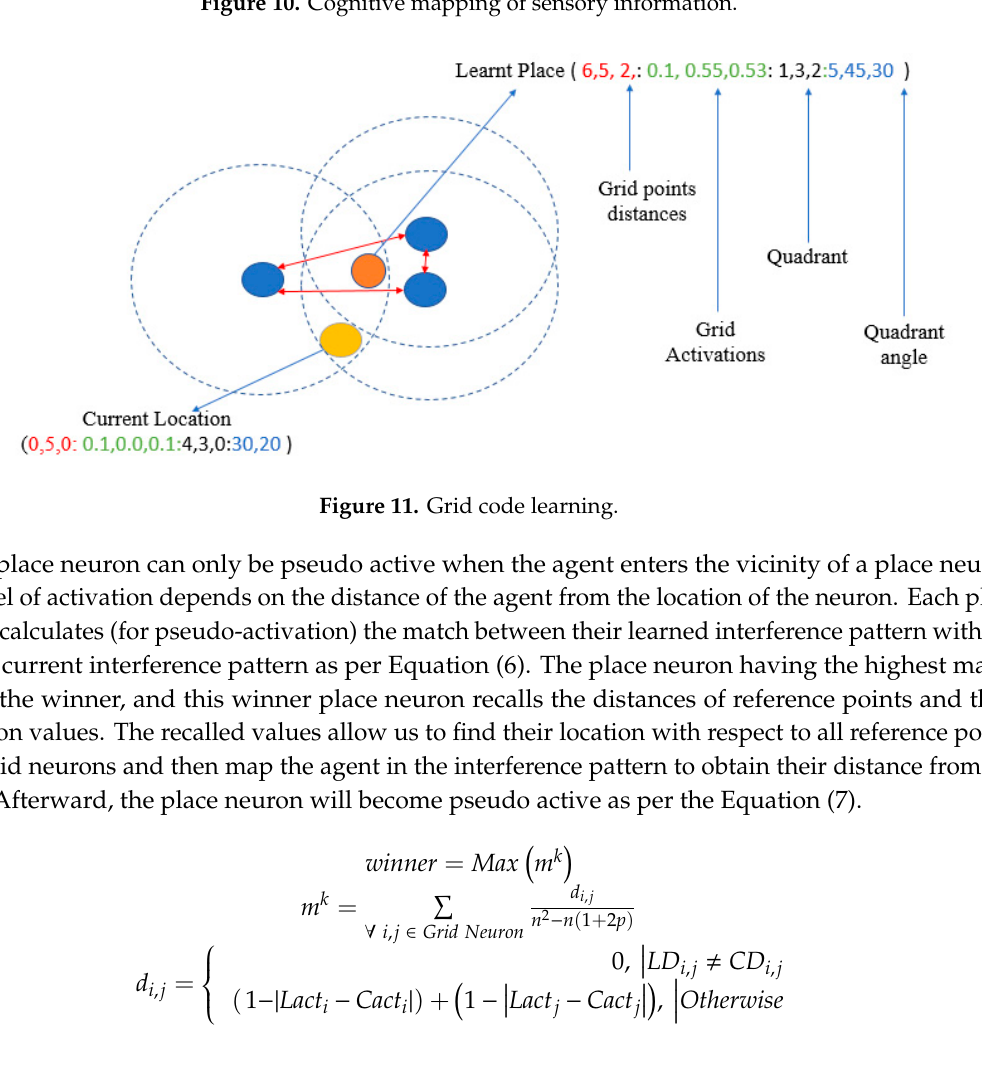
Figure 10. Cognitive mapping of sensory information.